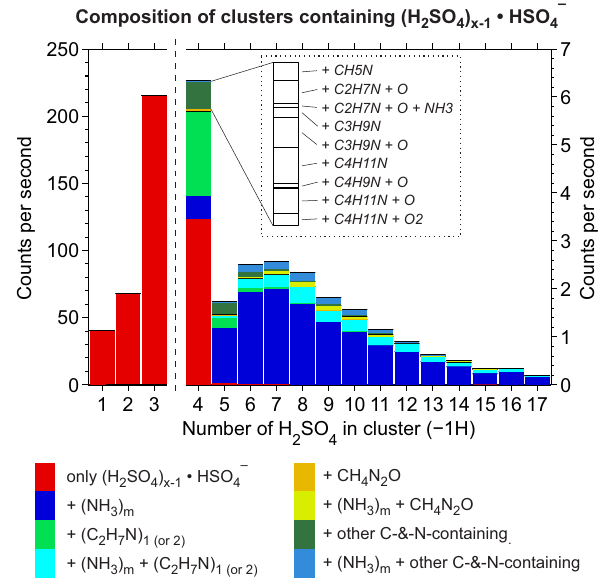
Figure 3. Details on the composition of the growing negatively charged clusters during the new-particle formation experiment pre- sented in Fig. 2, binned by the number x of H 2 SO 4 molecules in the cluster. Note that only ion clusters based on the HSO − shown, for simplicity. However, these ions constitute the majority of all ions, and practically all ions at x >3 (i.e., beyond 350Th, as can be seen in Fig. 2C). Note that besides contaminant NH 3 , a wide range of contaminant nitrogen-containing organic compounds are seen in these clusters if x>3, especially for x = 4. By far the most observed of these compounds is C 2 H 7 N (dimethylamine or ethy- lamine). Most likely all these organics are amines or amides (such as CH 4 N 2 O, probably urea), their high proton affinities facilitating the formation of clusters with H 2 SO 4